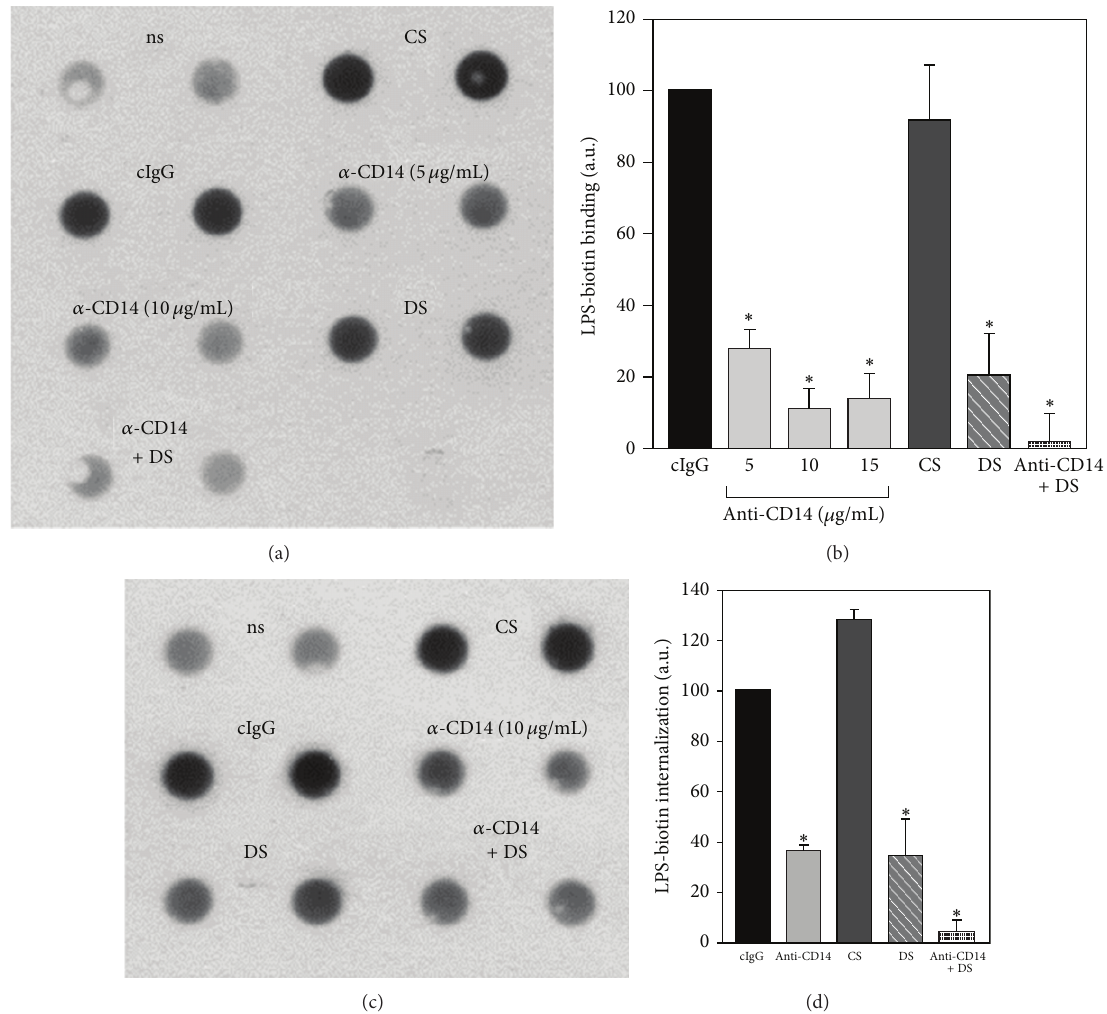
Figure 4: Binding of high doses of sLPS to the surface of RAW264 cells is mediated by CD14 and SR. (a, b) Binding of sLPS-biotin to the surface of RAW264 cells. Cells were preincubated with 0.05% NaN 3 (30 min, 37 ∘ C) and either left untreated (ns) or exposed to 5 or 10 𝜇 g/mL of the anti-CD14 antibody or 10 𝜇 g/mL isotype-matched control IgG (cIgG) or 50 𝜇 g/mL dextran sulfate (DS), or 50 𝜇 g/mL chondroitin sulfate (CS), or the mixture of 5 𝜇 g/mL anti-CD14 antibody and 50 𝜇 g/mL dextran sulfate. After 30 min (37 ∘ C), cells were stimulated with 1 𝜇 g/mL sLPS-biotin (1h, 37 ∘ C) in the constant presence of 0.05% NaN 3 . The amount of sLPS-biotin bound to the cell surface was assessed by dot-blot analysis of cell homogenates using streptavidin-peroxidase (a). (c, d) Internalization of sLPS-biotin. Cells were preincubated with 10 𝜇 g/mL anti-CD14 antibody or 10 𝜇 g/mL isotype-matched control IgG or 50 𝜇 g/mL dextran sulfate or 50 𝜇 g/mL chondroitin sulfate or a mixture of the anti-CD14 and dextran sulfate for 30 min at 37 ∘ C. Subsequently, the samples were supplemented with 1 𝜇 g/mL of sLPS-biotin for 1h and washed and incubated for another 1h at 37 ∘ C prior to homogenization and dot-blot analysis (c). (b, d) Quantification of cell surface-bound (b) and internalized (d) sLPS-biotin based on densitometric analysis of dot-blots. Data are mean ± SEM from three experiments. ∗ Significantly different from cells exposed to control